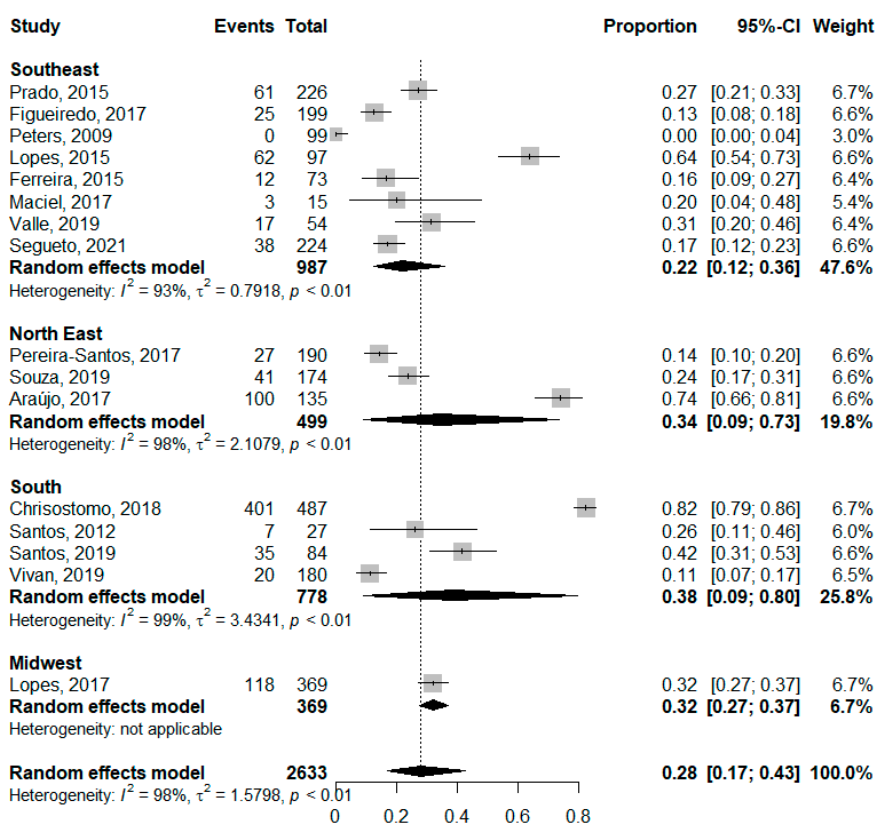
Figure 3. Prevalence of Vitamin D deficiency in childbearing women stratified by Brazilian geographic region. [33–37,39–48]. The vitamin D insufficiency (Figure 4) was of 59% (95% CI: 0.51–0.67; I 2 : 93%), with no differences between pregnant and non-pregnant women. A higher prevalence of vita- min D insufficiency was observed in the South region than in the other regions, although the confidence intervals did not show significant differences (Figure 5).